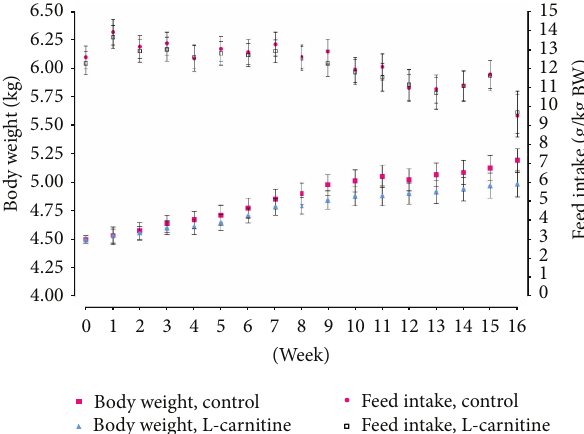
Figure 1: Mean ( ± SEM) food intake (g/kg/d) and BW (kg) in cats fed LC121 or LC188 receiving 120% of their maintenance energy requirement on a per kg basis during 16-week